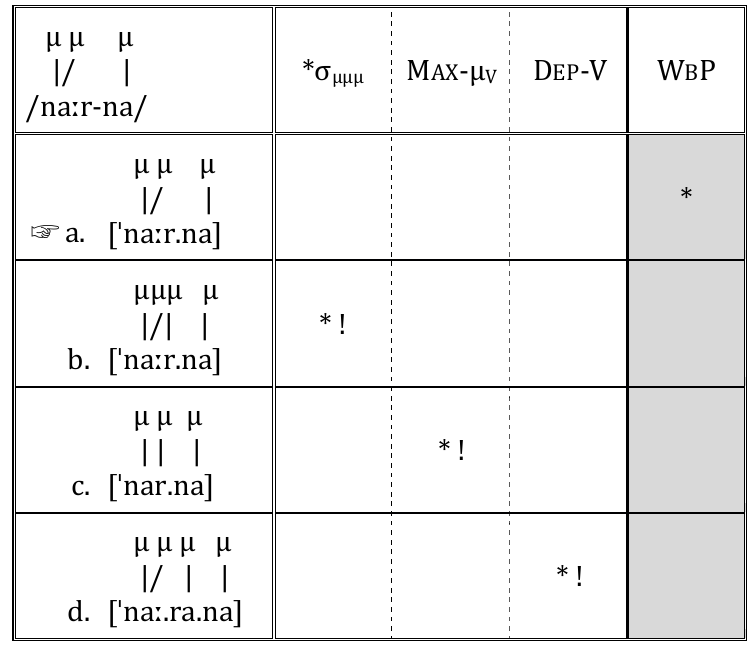
Tableau 7: Since W B P is ranked low, the fully faithful candidate is allowed to surface, and epenthesis of a vowel, epenthesis of a mora, and vocalic mora deletion are not allowed to